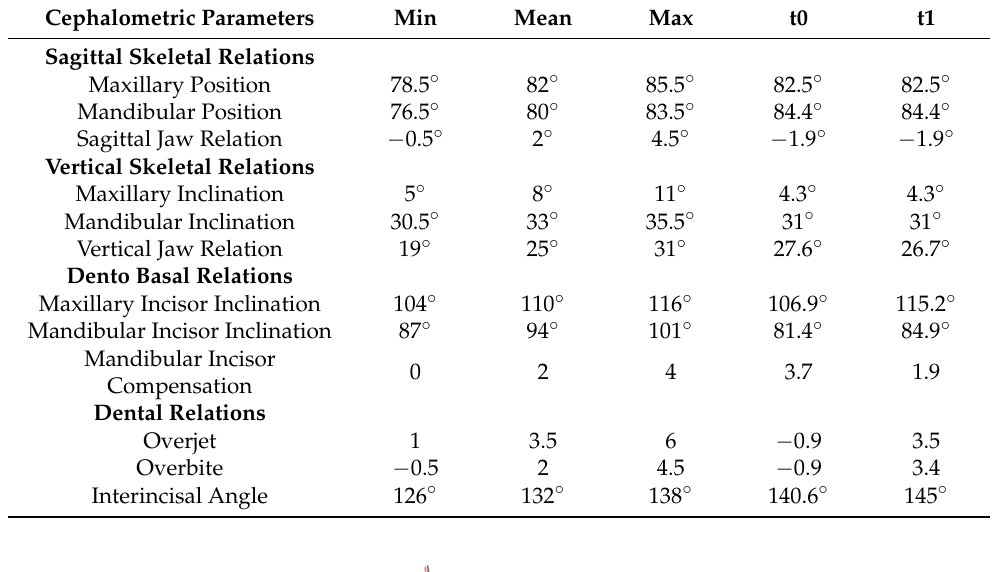
Table 3. Comparison of pre- (t0) and post- (t1) cephalometric values.